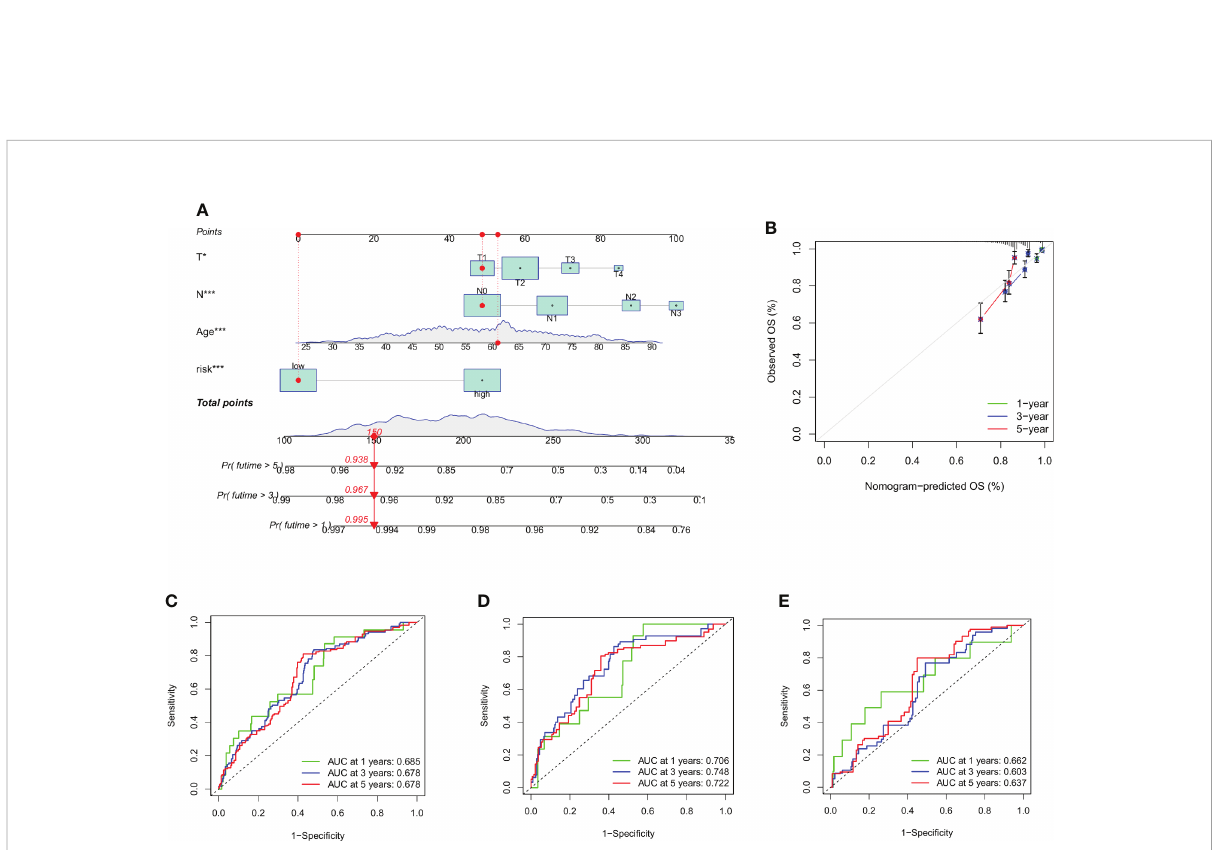
FIGURE 7 Creating and evaluating a nomogram. (A) The nomogram used to calculate the survival rates of 1-, 3-, and 5-years for patients with BC. (B) Calibration curve for nomograms. (C – E) ROC curves for the train set and test set, respectively, for forecasting 1-, 3-, and 5-year OS in the cohorts. *p < 0.05, ***p <